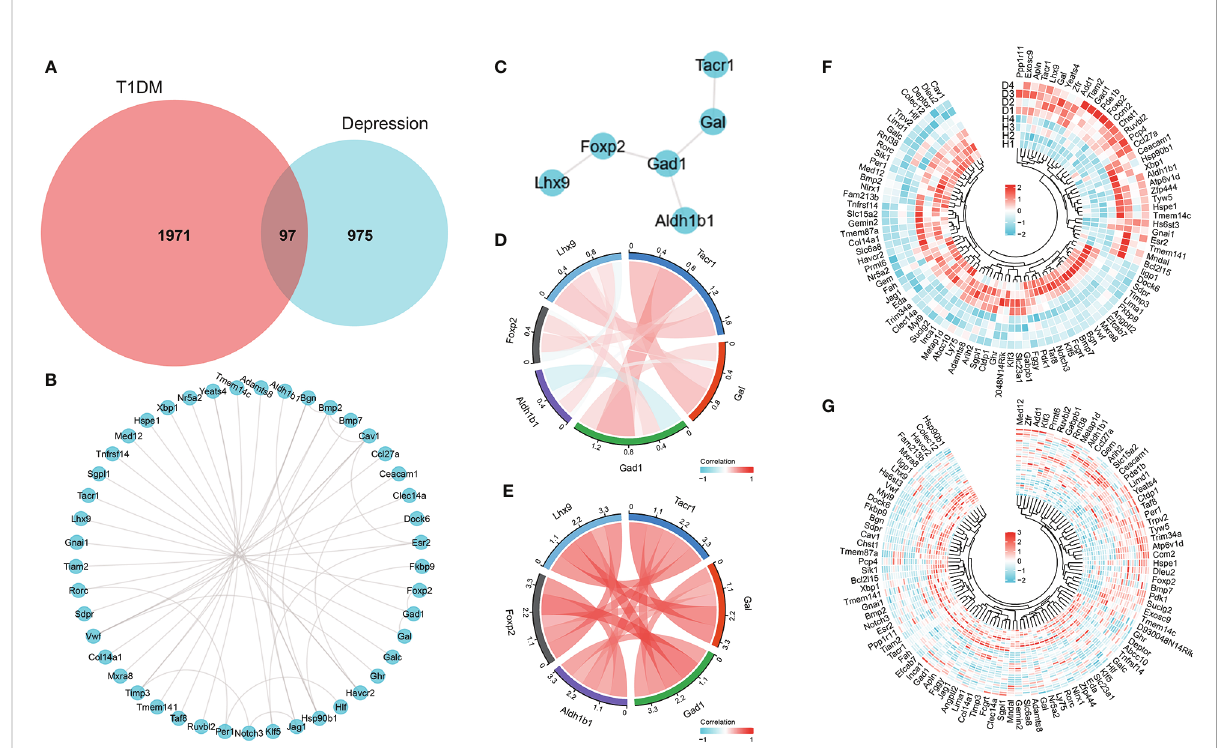
FIGURE 3 (A) Overlapped genes of differential expression analysis in both GSE37450 and GSE198597 dataset. (B) Interaction network of overlapped genes. (C) Interaction of NK1R-related genes in overlapped gene sets. (D) Pearson analysis of NK1R-related genes in overlapped gene sets in GSE37450 dataset. (E) Pearson analysis of NK1R-related genes in overlapped gene sets in GSE198597 dataset. (F) Heatmap of NK1R-related genes in overlapped gene sets in GSE37450 dataset. (G) Heatmap of NK1R-related genes in overlapped gene sets in GSE198597